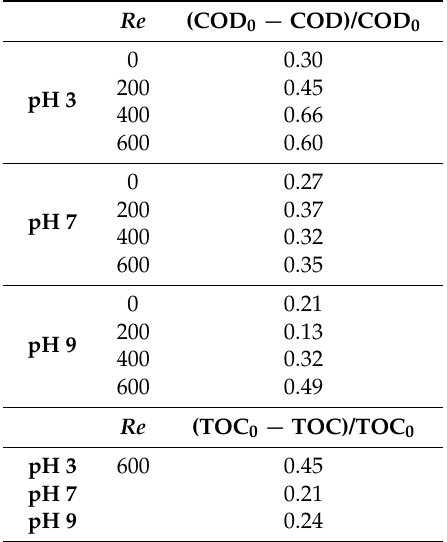
Table 3. Chemical oxygen demand (COD) efficiency values for the nanostructures anodized at the different Re values and for the different pH values and total organic carbon (TOC) efficiency values for the nanostructures anodized at Re = 600 and at the different pH